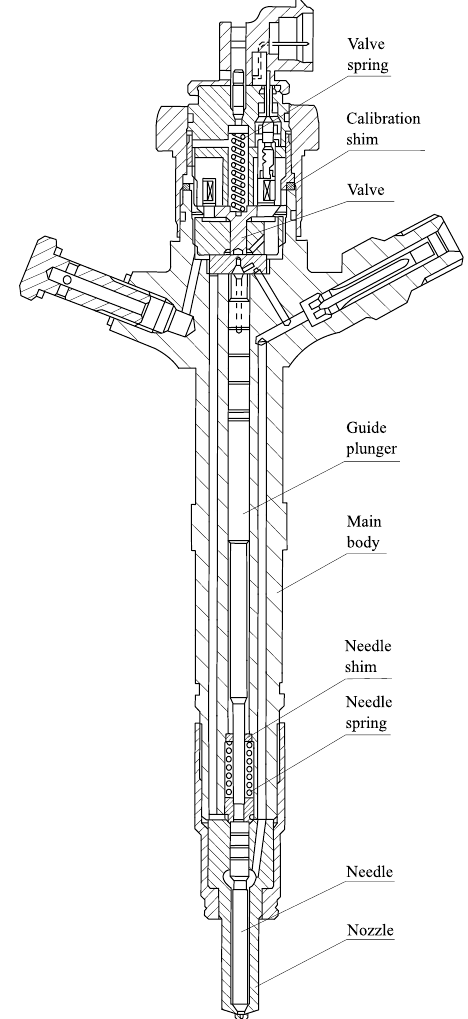
Fig. 1. Denso injector